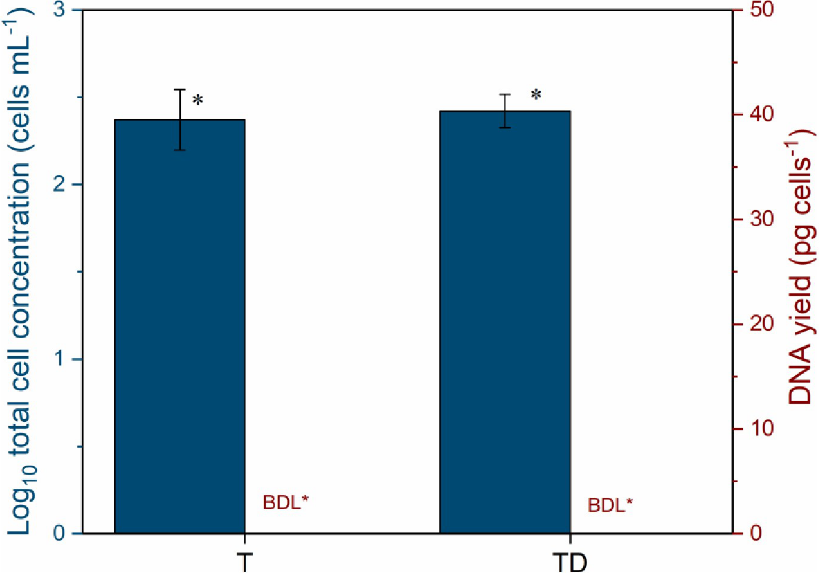
Fig 3. Cell concentration and DNA yield obtained from (T) tap water with residual chlorine and (TD) dechlorinated tap water. The tap (drinking) water treatments were done by maintaining or removing residual chlorine, as summarized in Fig 2. A blue-coloured star indicates that total bacterial cell concentration was below the limit of detection (LOD) of flow cytometry which is 10 3 cells/mL. A red-coloured star indicates that the DNA concentration measured was below detection limit (BDL) of Qubit High Sensitivity assay dsDNA � 0.01 ng/ μ L. The error bars show errors from three independent